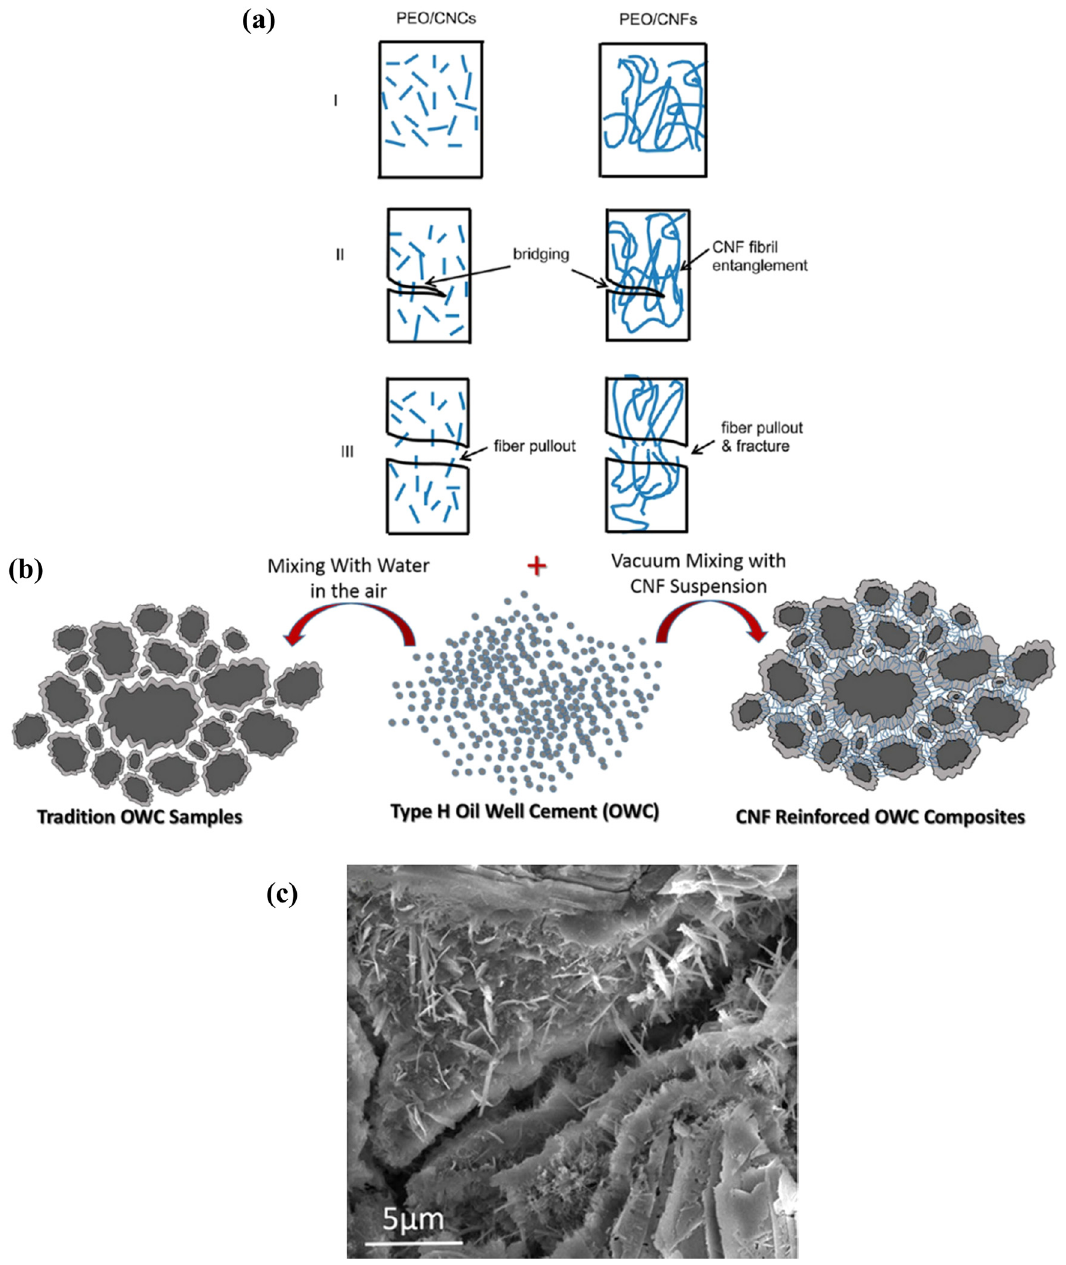
Figure 25: ( a ) Illustration of fracture mechanisms of polyethylene oxide ( PEO ) /CNC and PEO/CNF nanocomposites [ 149 ] ; Copyright 2013, American Chemical Society; ( b ) scheme of CNF reinforced oil well cement composites; ( c ) SEM image of CNF reinforced OWC composites with 0.04 wt% CNF loading [ 34 ] ; Copyright 2016, Nature